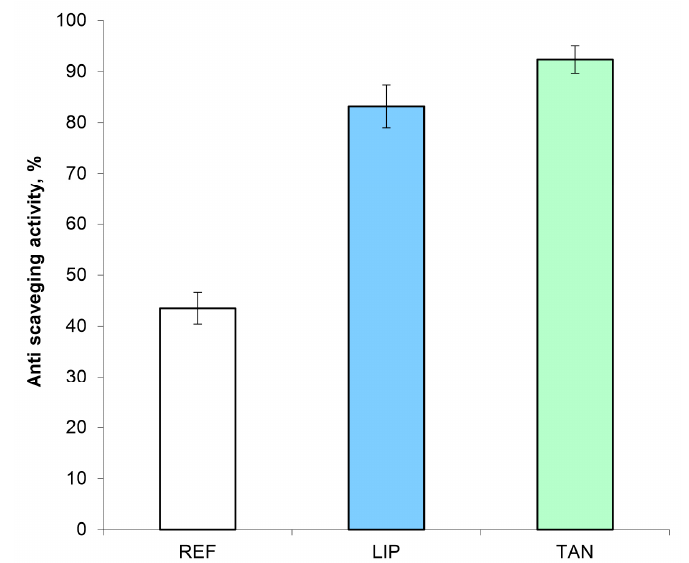
Figure 7. Antiradical activity of the obtained biomaterials.